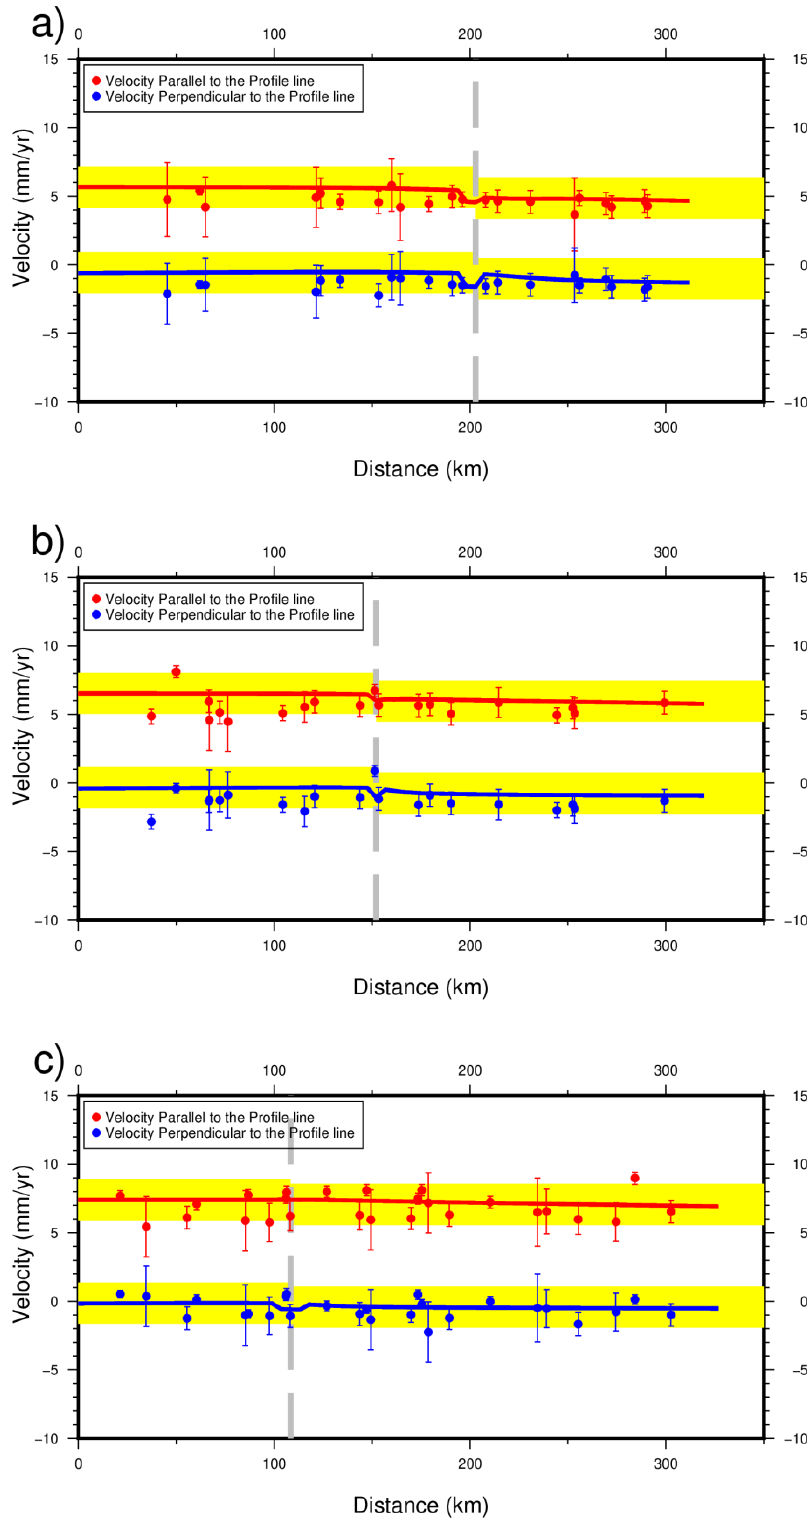
Figure 6. GPS velocity profiles from north to south ( a – c ). The length of the profiles is less than 350 km, and the width is 160 km. The red points and lines represent the observed and calculated GPS velocity parallel to the profile lines, respectively. The blue points and lines represent the observed and calculated GPS velocity perpendicular to the profile lines. The gray dashed line represents the Tanlu fault zone, and the median value of the yellow rectangle is the average of the velocities.